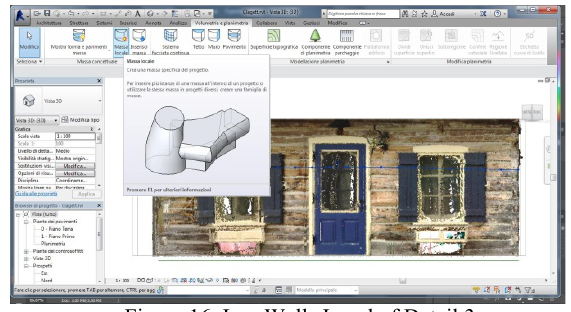
Figure 16. Log Walls Level of Detail